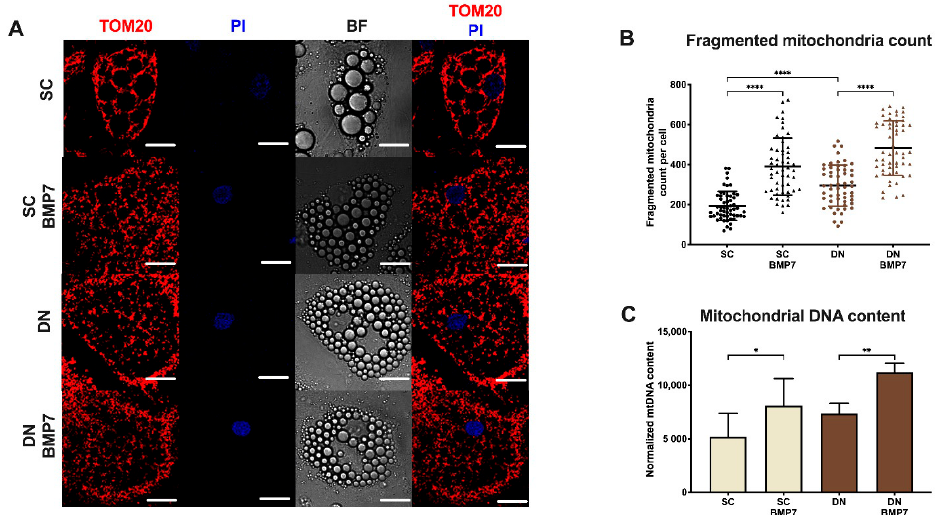
Figure 4. Fragmented and total mitochondrial content were increased upon BMP7 treatment in SC and DN derived differentiated adipocytes. SC and DN preadipocytes were differentiated and treated as in Figures 1–3. ( A ) Representative confocal microscopy images of TOM20 immunostaining. PI was used to stain the nucleus. Scale bars represent 10 μ m. ( B ) Quantification of fragmented mitochondrial content normalized to per nuclei ( n = 55 cells of 3 donors); ( C ) total mitochondrial DNA content quantified by qPCR (n = 5). Data expressed as mean ± SD. * p < 0.05, ** p < 0.01, **** p < 0.0001. Statistics: one-way ANOVA with Tukey’s post-test.